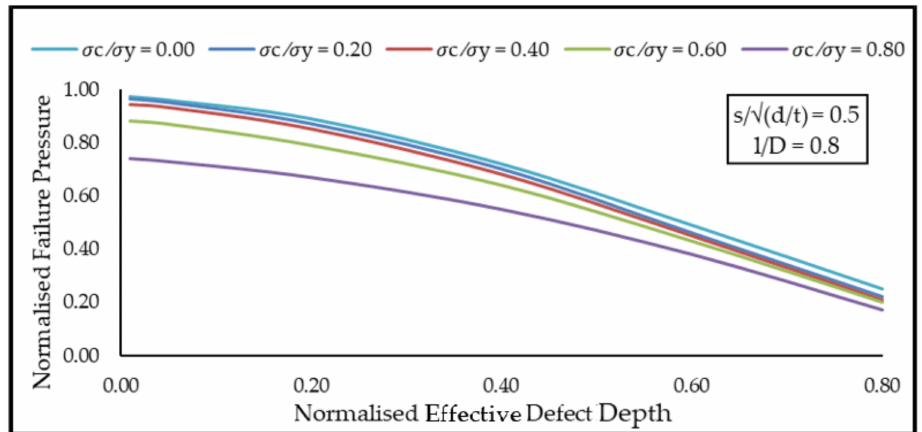
Figure 15. Normalized failure pressure predictions of the new assessment method against various normalized defect depth for multiple axial compressive stresses at a constant normalized defect spacing of 0.5 and normalized defect length of 0.80.